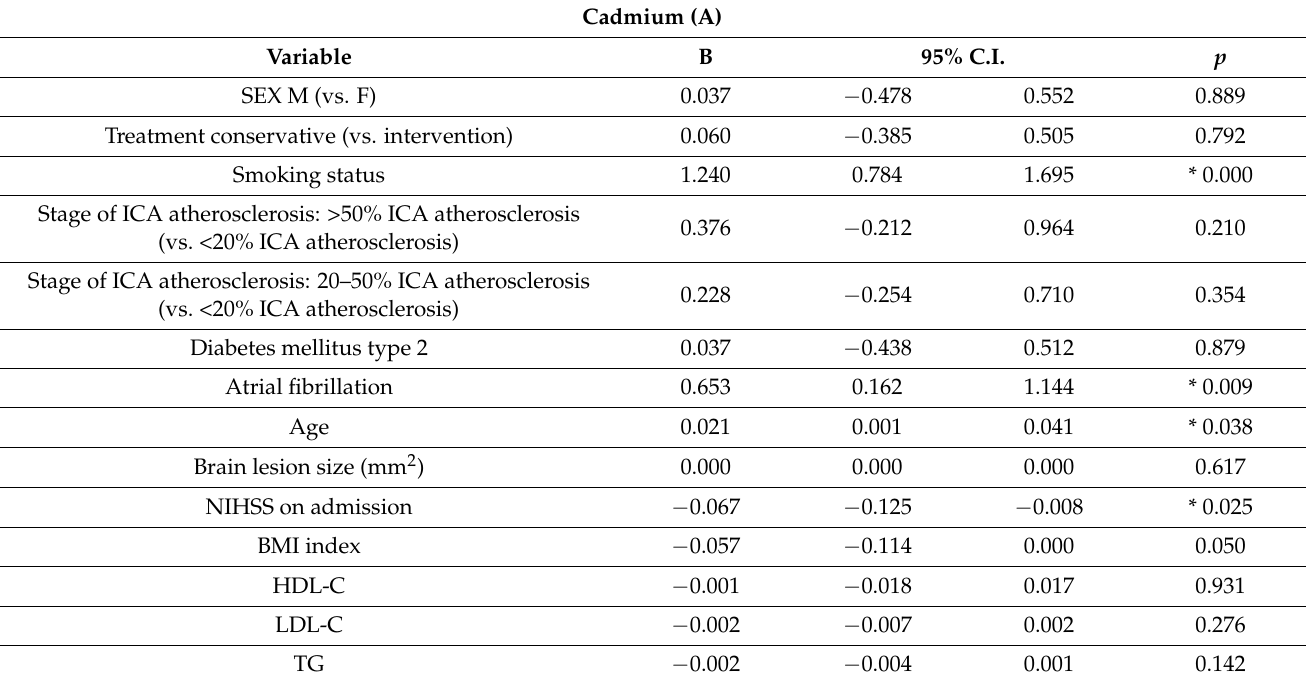
Table 4. Generalized linear regression models for Cd ( A ), Pb ( B ), Cd/Zn molar ratio ( C ) in AIS